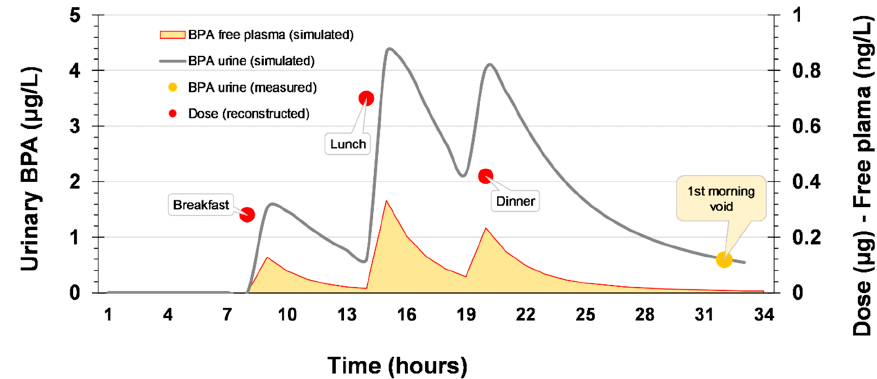
Figure 2. Exposure reconstruction levels.